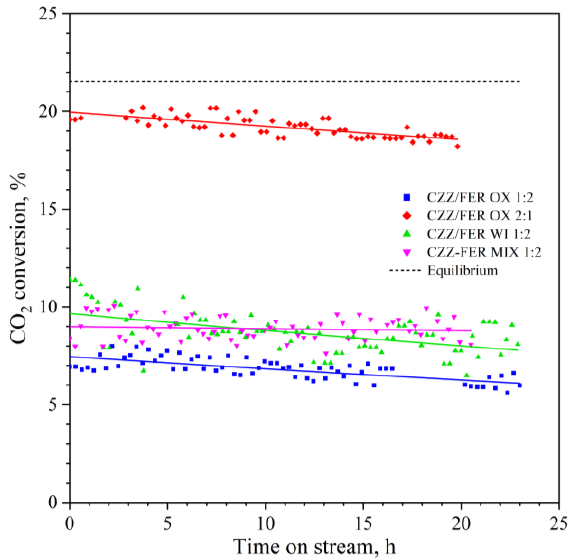
Figure 8. CO 2 conversion during stability tests (~20 h). Reaction conditions: 2.5 MPa; 275 °C; inlet H 2 /CO 2 /N 2 , 3/1/1 mol/mol; WHSV, 13.3 N L∙g cat −1 ∙h −1 . The solid lines represent the interpolated exponential function of the catalyst deactivation.